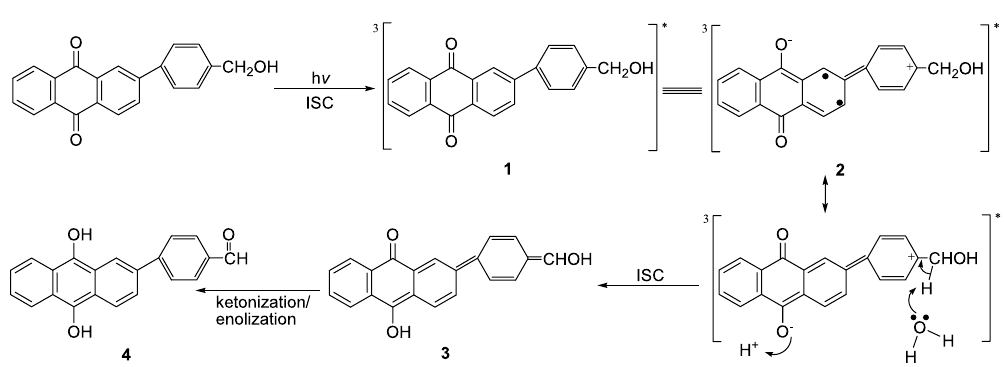
Figure 2. A proposed concerted reaction mechanism of the photoredox reaction of PPAQ in acid aqueous solutions based on that of ref.